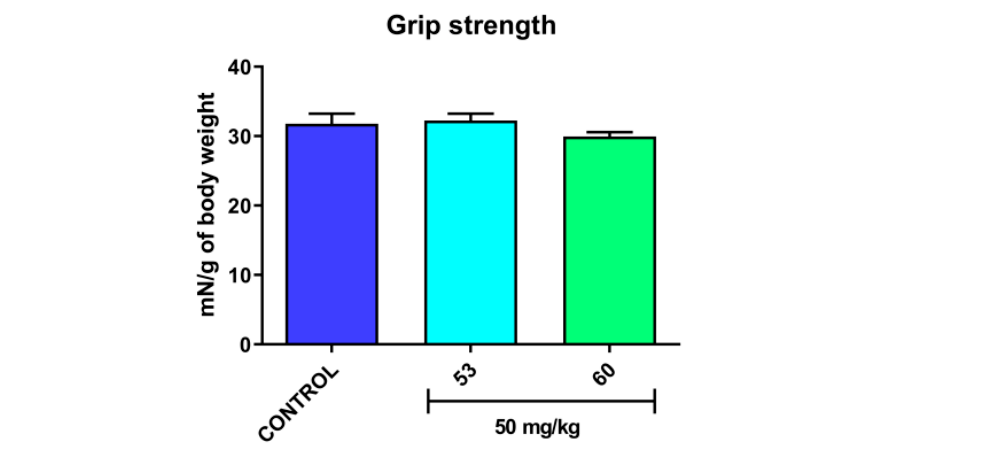
Figure 3. Acute effects of 53 and 60 on the neuromuscular strength in mice. Compounds 53 and 60 were administered i.p. 0.5 h before the seizure test. Control animals received vehicle only. Each experimental group consisted of 9–10 animals. Each bar represents the mean + SEM grip strengths in millinewtons per gram of mouse body weight (mN/g).